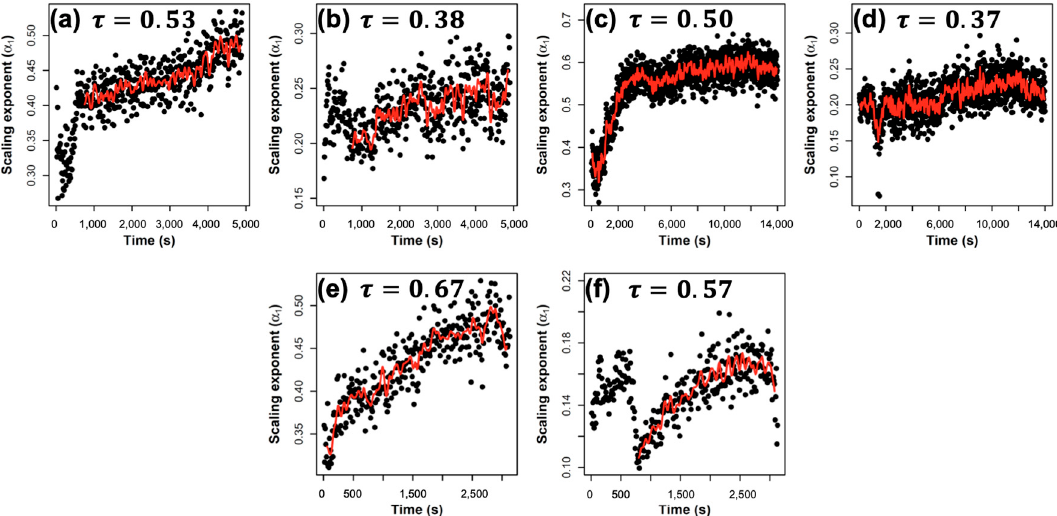
Figure 9. The scaling exponents ( α 1 ) of non-overlapping 2560-sample segments of the vibration signals toward bearing failure: ( a ) data set 3_1 (horizontal); ( b ) data set 3_1 (vertical); ( c ) data set 3_2 (horizontal); ( d ) data set 3_2 (vertical); ( e ) data set 3_3 (horizontal); ( f ) data set 3_3 (vertical) .